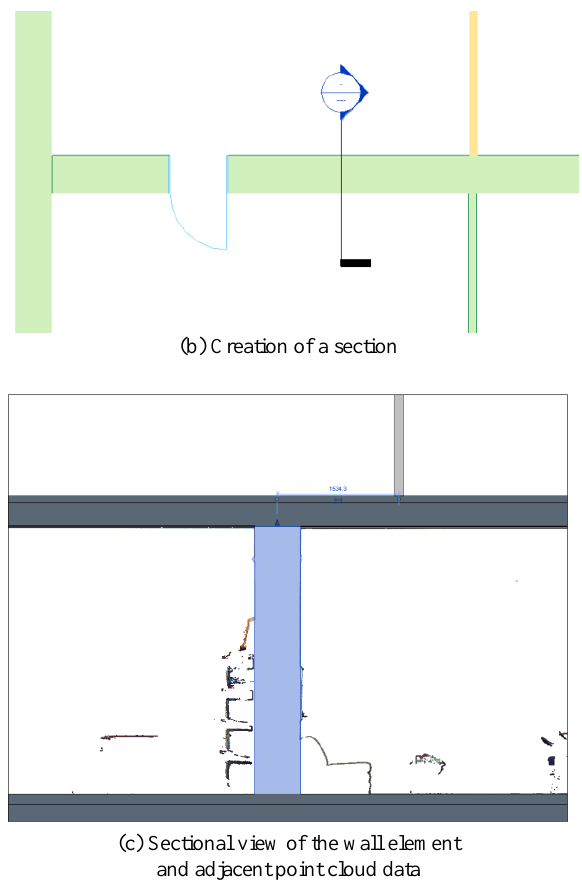
Figure 1: Creation of a sectional view along a wall element for the verification of the wall modelling from a point cloud This method can be time-consuming — notably for large BIM projects — and it limits the verification of the model to specific section locations. Moreover, as highlighted by (Anil et al. 2013), while a visual inspection is a straightforward method and